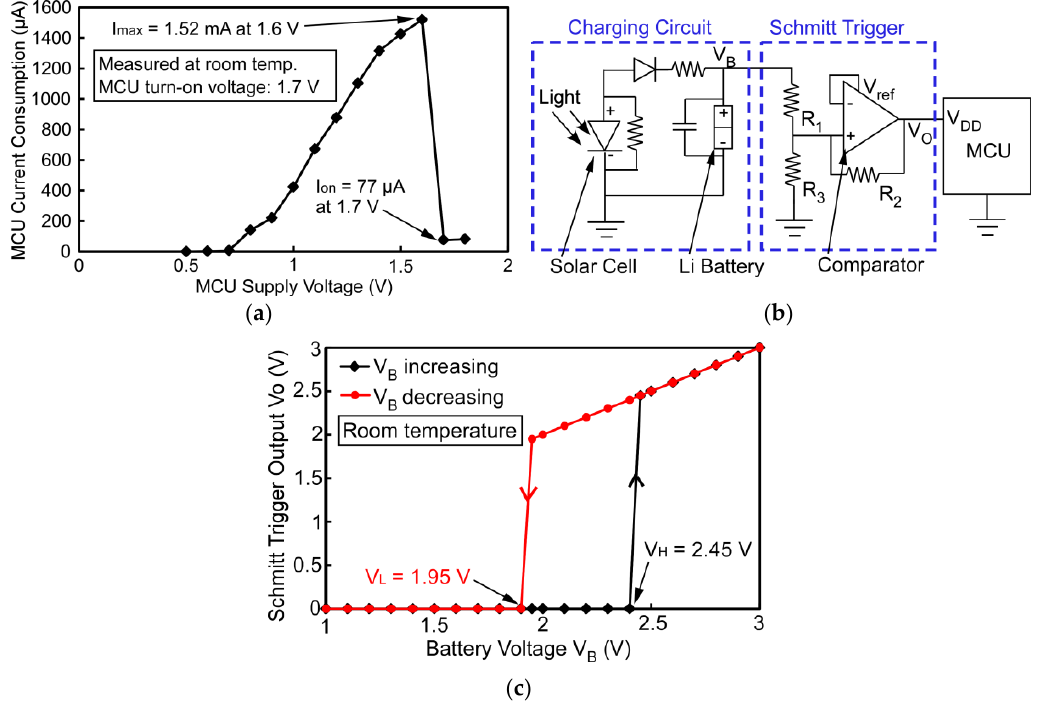
Figure 4. ( a ) Measured static current consumption of the C8051F990 MCU when the supply voltage is at or below the minimum operation voltage (1.8 V) specified in the MCU datasheet. A significant current spike, which peaks at 1.6 V supply voltage, is observed; ( b ) Schematic of the power supply